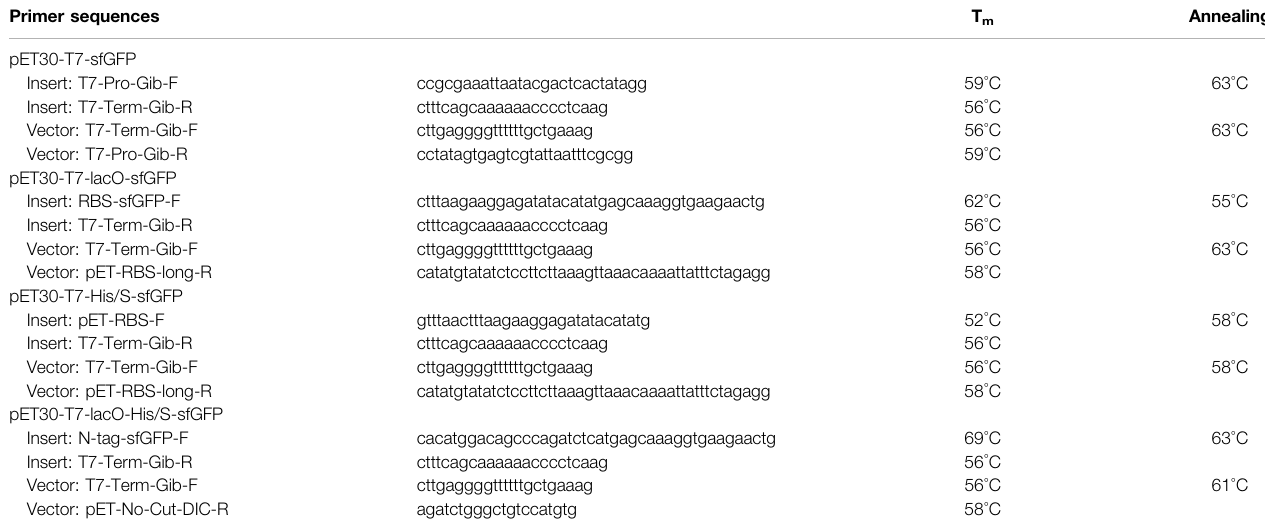
TABLE 1 | Primers used to construct pET30 expression vectors. Primers for ampli fi cation of insert and vector backbones used in Gibson assembly to construct pET30-T7- sfGFP, pET30-lacO-sfGFP, pET30-His-sfGFP, and pET30-lacO-His-sfGFP. Primer